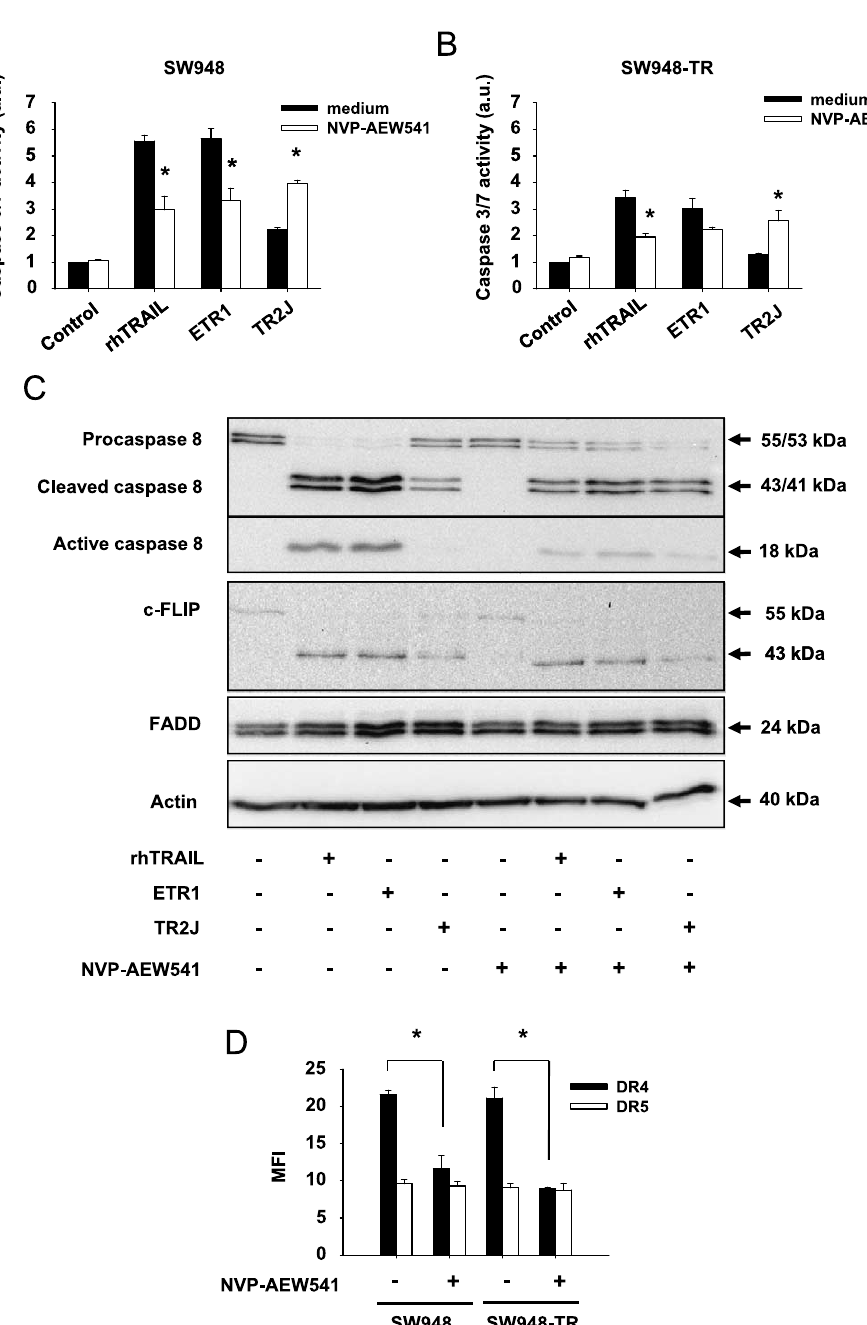
Fig. 2. IGF-1R inhibition modulates DR-mediated apoptosis and downregulates surface DR4 expression. Modulation of rhTRAIL or agonis- tic antibody induced apoptosis by NVP-AEW541 in SW948 (A) and SW948-TR (B), as assessed by caspase 3/7 activity assay. Cells were pre-incubated for 15–18 h with 5 µM NVP-AEW541, then either left untreated or exposed to rhTRAIL (0.1 µg/ml), HGS-ETR1 (50 nM) or HGS-TR2J (50 nM) for 3 additional hours before harvest. Caspase 3/7 activity is expressed in arbitrary units (a.u.), as the ratio of caspase 3/7 activity in treated cells to untreated cells. Values are mean ± SE of at least three independent experiments. (C) Western blot analysis of the expression levels of several proteins located downstream from the TRAIL receptors, after IGF-1R inhibition and treatment with rhTRAIL or agonistic DR antibody, in SW948. The cells were pre-incubated for 15–18 h with 5 µM NVP-AEW541, then either left untreated or exposed for 3 additional hours with rhTRAIL (0.1 µg/ml), HGS-ETR1 (50 nM) or HGS-TR2J (50 nM) before harvest. (D) Surface expression of TRAIL receptors in SW948 and SW948-TR, in control cells and after 15–18 h exposure to 5 µM